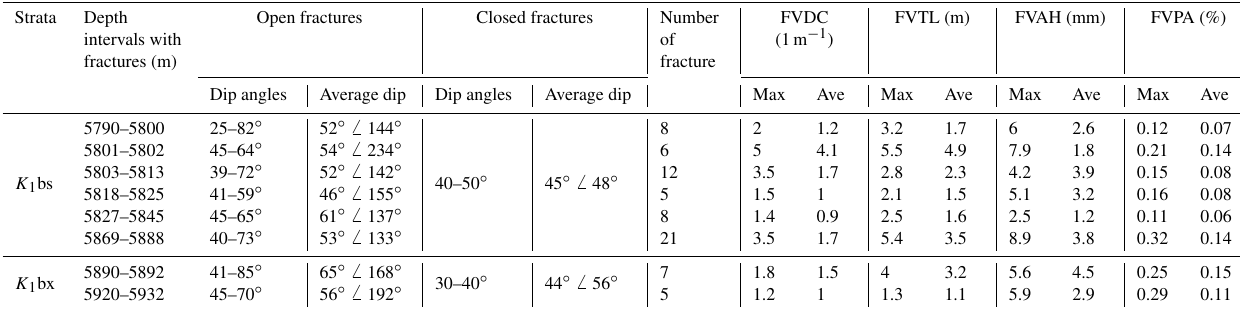
FVDC FVTL (m) FVAH (mm) FVPA (%) of (1m − 1 ) fracture